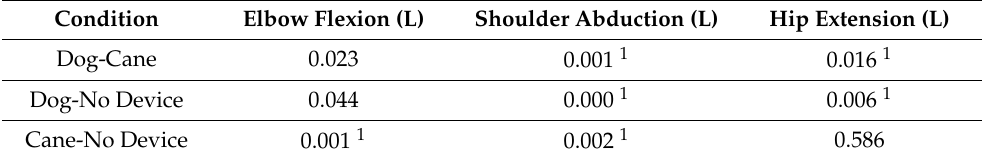
Table 3. Results of post-hoc Wilcoxon Signed-Rank Test for joint angles with statistically significant differences (as identified through Friedman’s